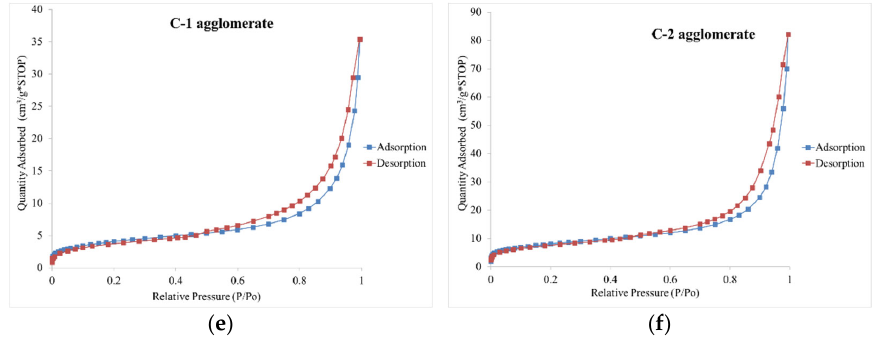
Figure 20. Absorption ‐ desorption isotherms of nitrogen for the manufactured agglomerates ( a – f ).